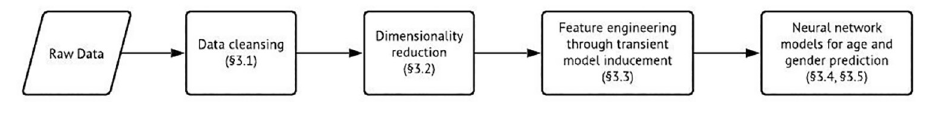
Fig 1. Summary of our approach to